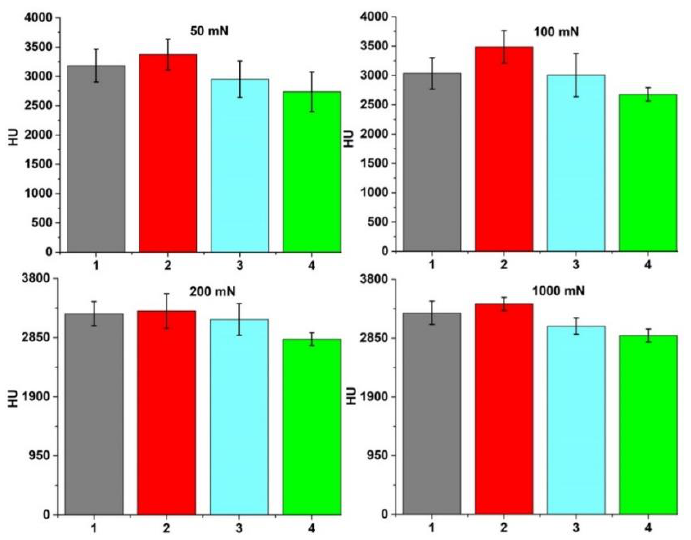
Figure 5. Ultra HV measurements of samples: (1) quenched in oil, (2) quenched in water, (3) without thermal treatment, and (4) quenched in the oven .